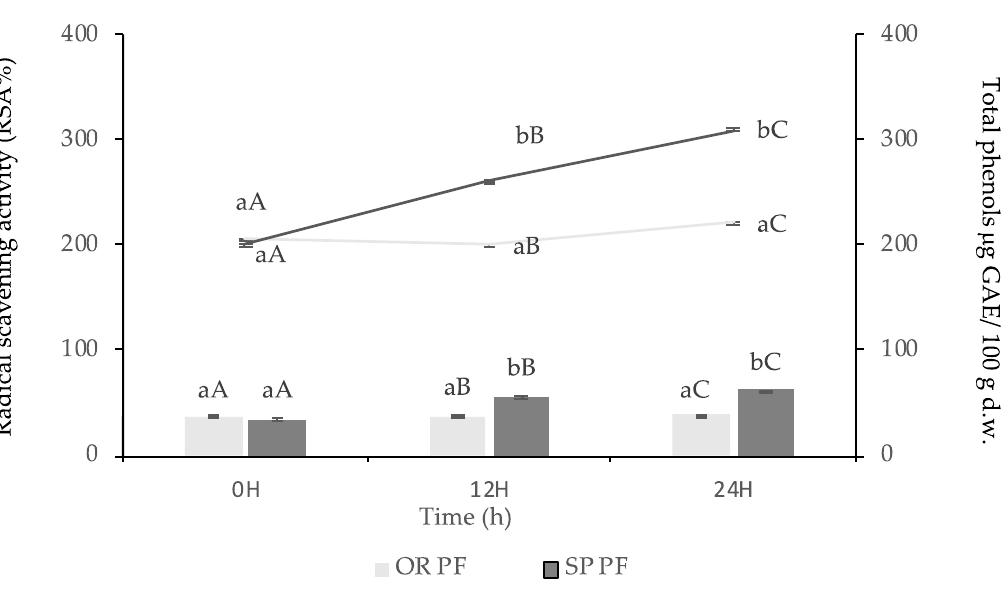
Figure 6. Radical scavenging activity and phenolic compounds content of final baked goods methanolic extracts during 0, 12, 24H made with sourdoughs with L. spicheri DSM 15429 (SP PF) and without L. spicheri DSM 15429 (OR PF), (Values not sharing the same small letters indicate the significant di ff erence between OR and SP at the same moment: 0, 12, 24H, (Values not sharing the same capital letters indicate the di ff erence between OR and SP at di ff erent moments: 0, 12, 24H); d.w., dry